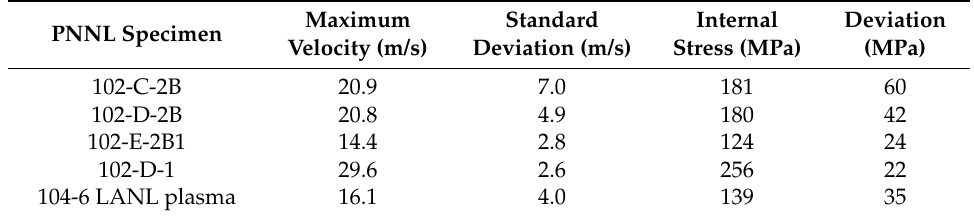
Table 4. Maximum velocities are converted into estimates of threshold interface debond strength for the FF plates.